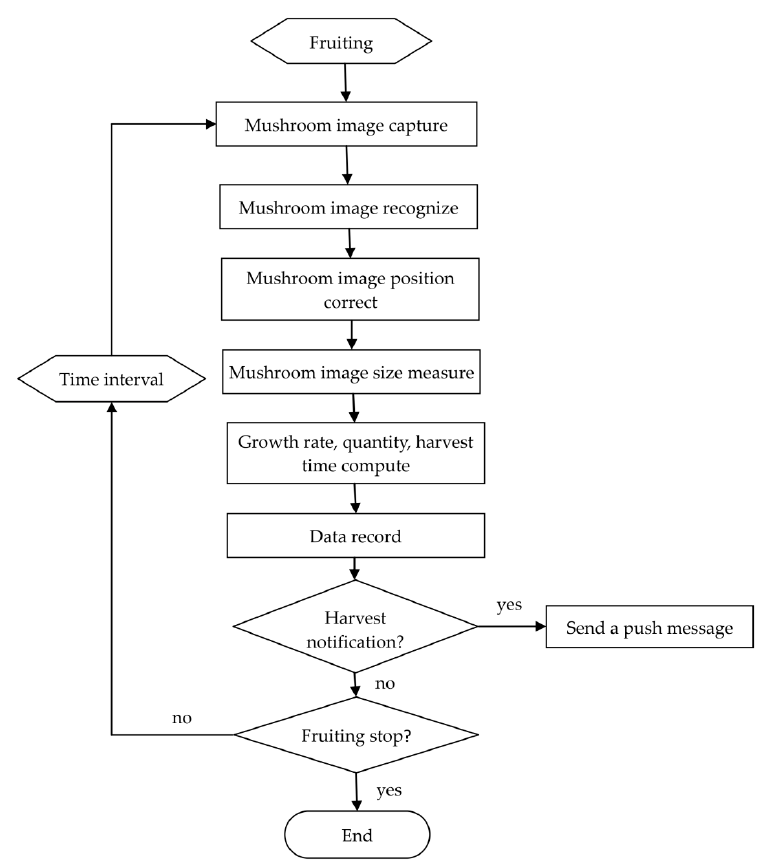
Figure 4. The flowchart of the measurement system.